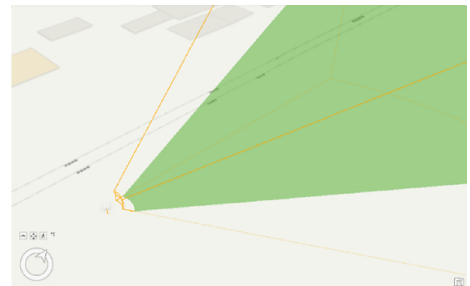
Figure 5. Scenario of 3D FOV and terrain.